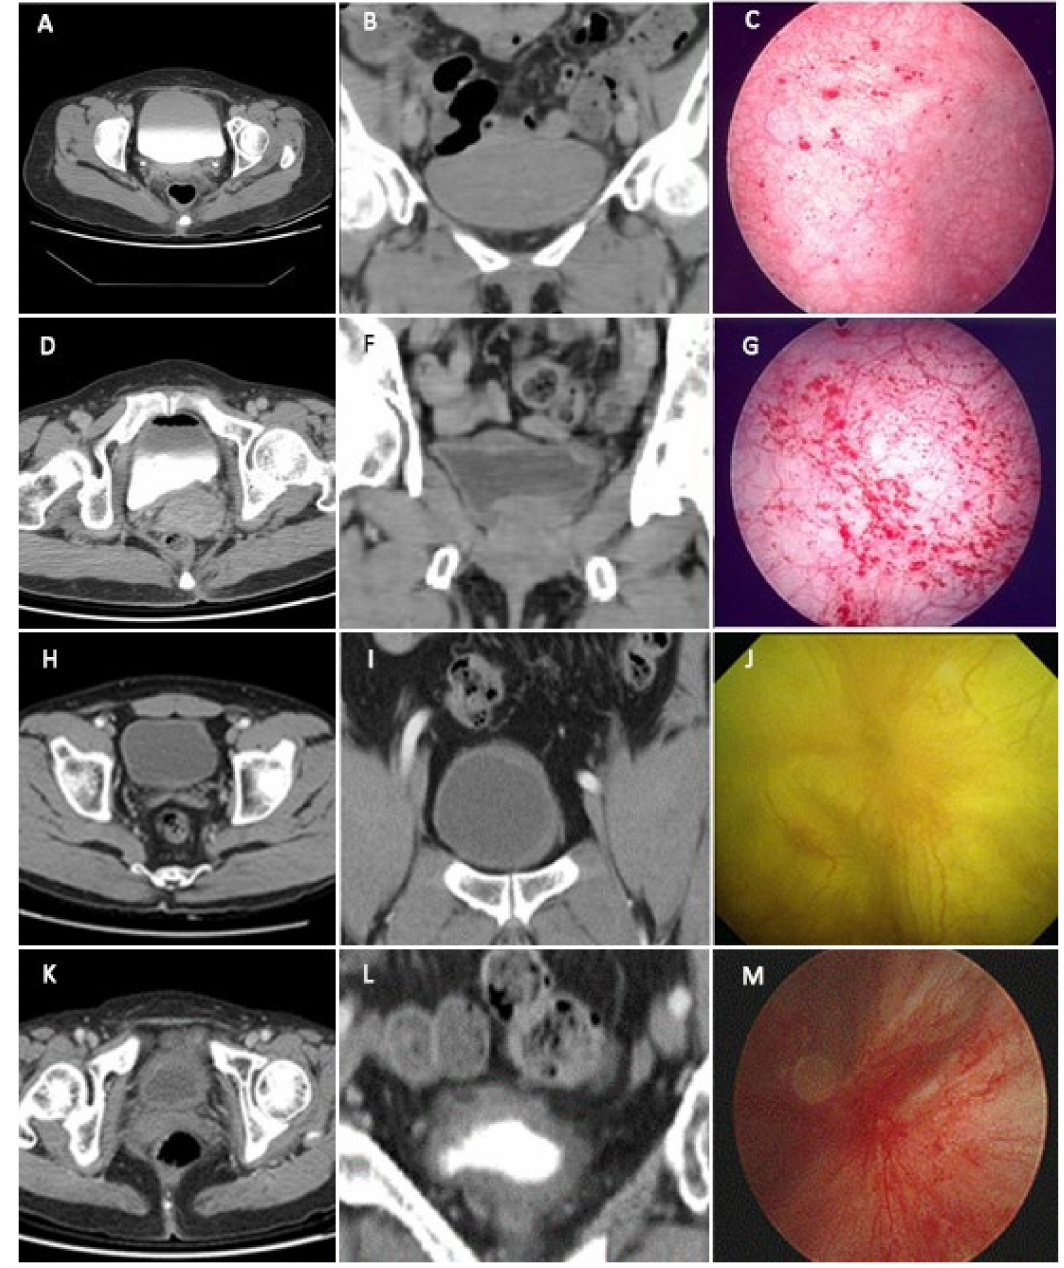
Figure 2. Bladder wall thickness and cystoscopic HD features in patients with interstitial cystitis/bladder pain syndrome. ( A – C ) Patient with smooth bladder wall and grade 1 glomerulation; ( D – G ) patient with focal thickening bladder wall and grade 2 glomerulation, ( H – J ) patient with focal thickening bladder wall and Hunner’s lesion; ( K – M ) patient with diffuse thickening bladder wall and Hunner’s